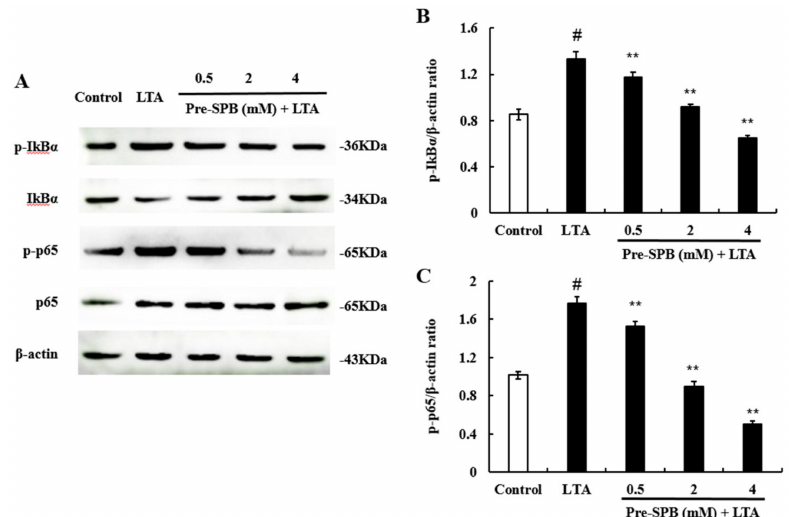
Figure 4. The effect of SPB on NF-Kb activation. The NF- κ B pathway was explored in MAC-T cells using Western blot analysis. β -actin was used as a reference control. ( A ) The expression levels of p-I κ B α , I κ B α , p-p65 and p65; ( B ) The quantification histogram of p-I κ B α protein expression normalized by β -actin; and ( C ) The quantification histogram of p-p65 protein expression normalized by β -actin. The values presented are the means ± SE of three independent experiments. # p < 0.05 vs. control group; ** p < 0.01 vs. LTA group.